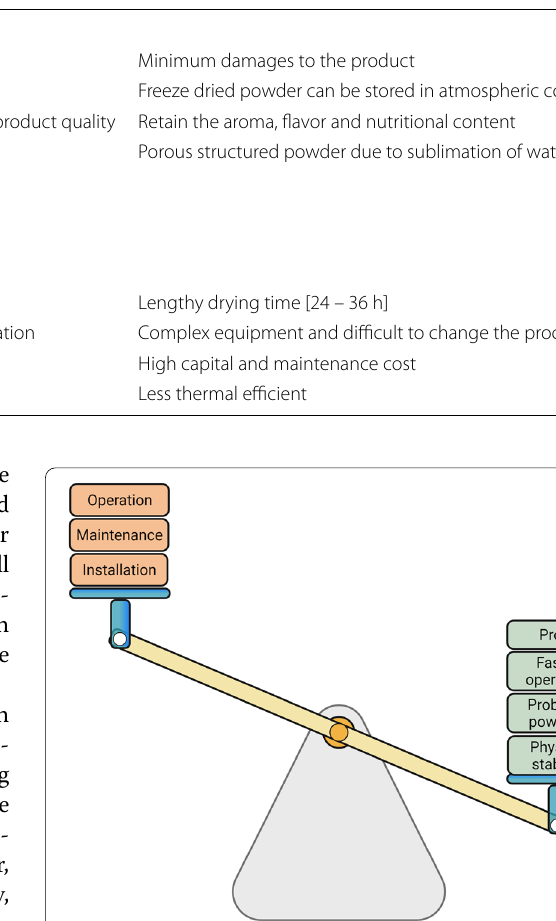
Table 1 Advantages and disadvantages of encapsulation technologies Sl. No